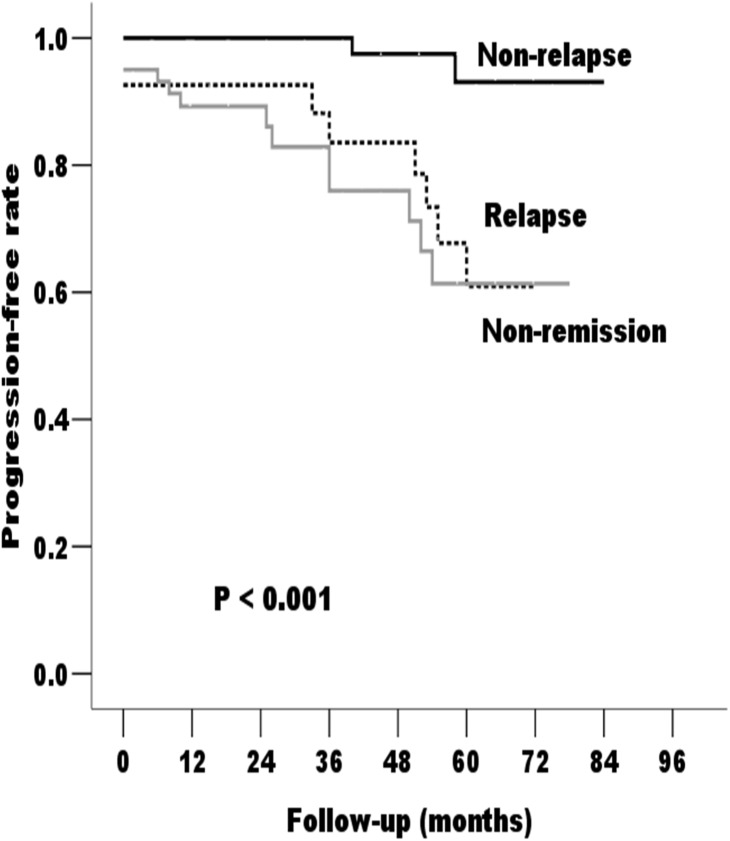
Kaplan-Meier cumulative renal progression-free survival rate according to the incidence of non-relapse, relapse, and non-remission during the follow-up period of the Primary Cohort.The non-relapse patients had significantly longer progression-free times compared with the relapse and non-remission patients (P < 0.05).